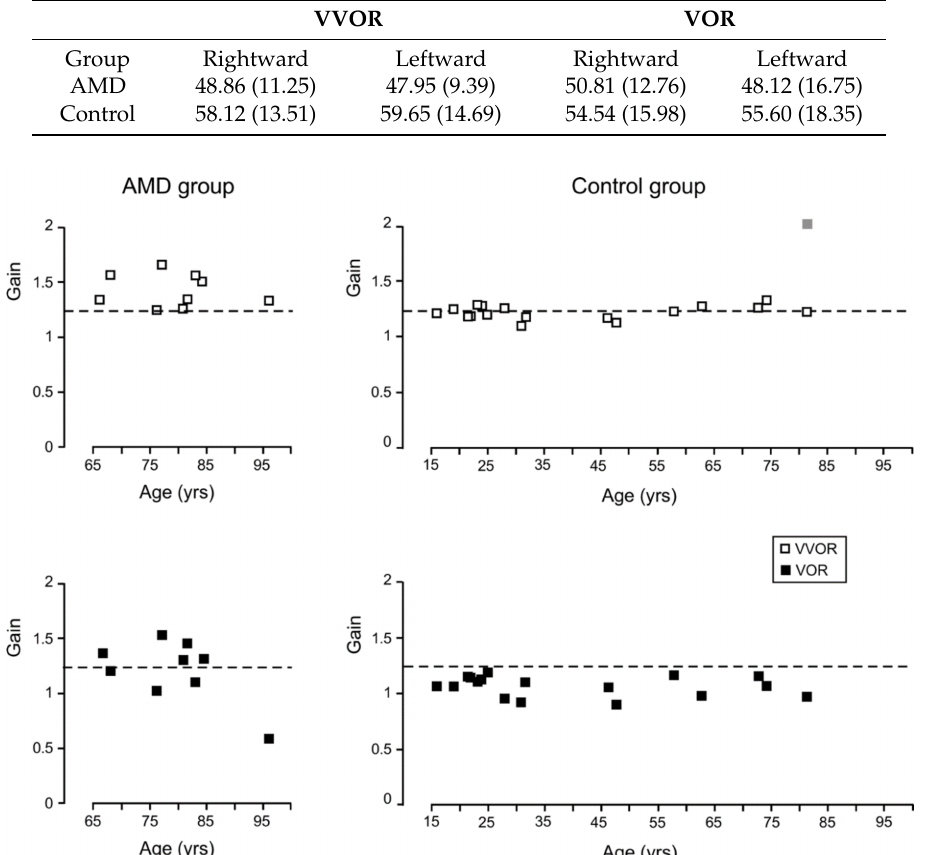
Table 4. Mean peak head velocities (SD) during VVOR and VOR.